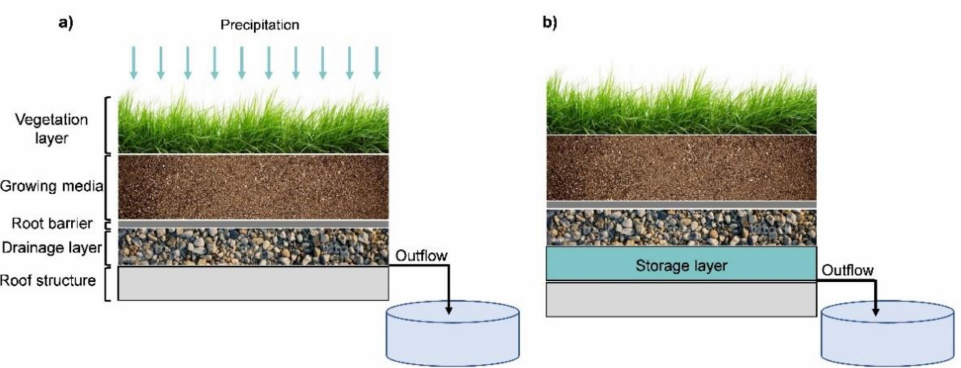
Figure 1. Green roofs designs. ( a ) Usual layers of a green roof. ( b ) Example of a green–blue roof with storage layer to prevent flash floods. In both cases, the use of a stormwater harvesting reservoir connected with the outflow is optional and not so common; however, it adds more possibilities for real-time control